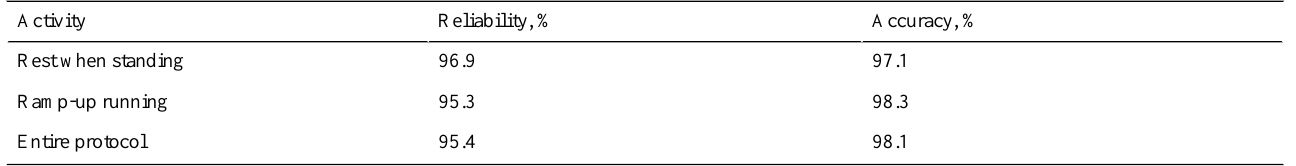
Table 2. Accuracy of wrist optical heart rate device during treadmill running up to maximum speed.